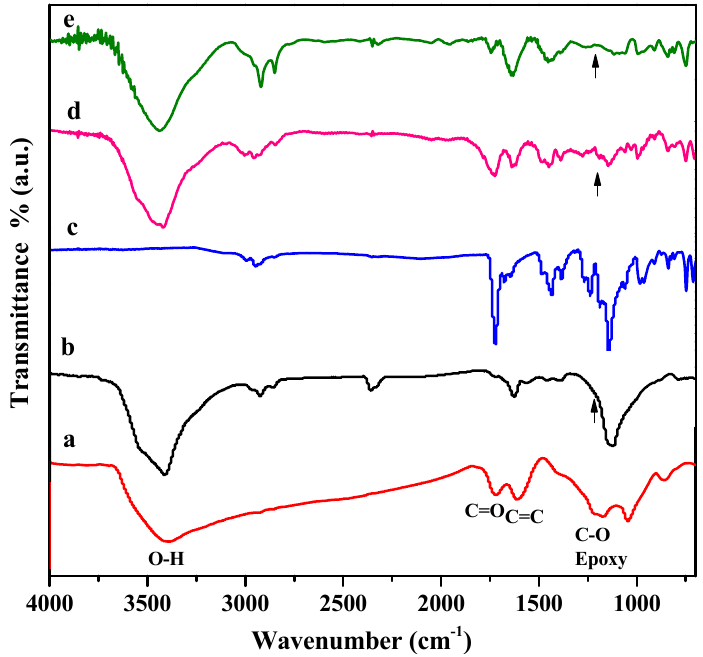
Figure 1. FTIR spectra of ( a ) GO; ( b ) RGO; ( c ) neat PMMA; ( d ) RGO-(PMMA) nanocomposites and ( e ) R-(GO-PMMA) nanocomposites.